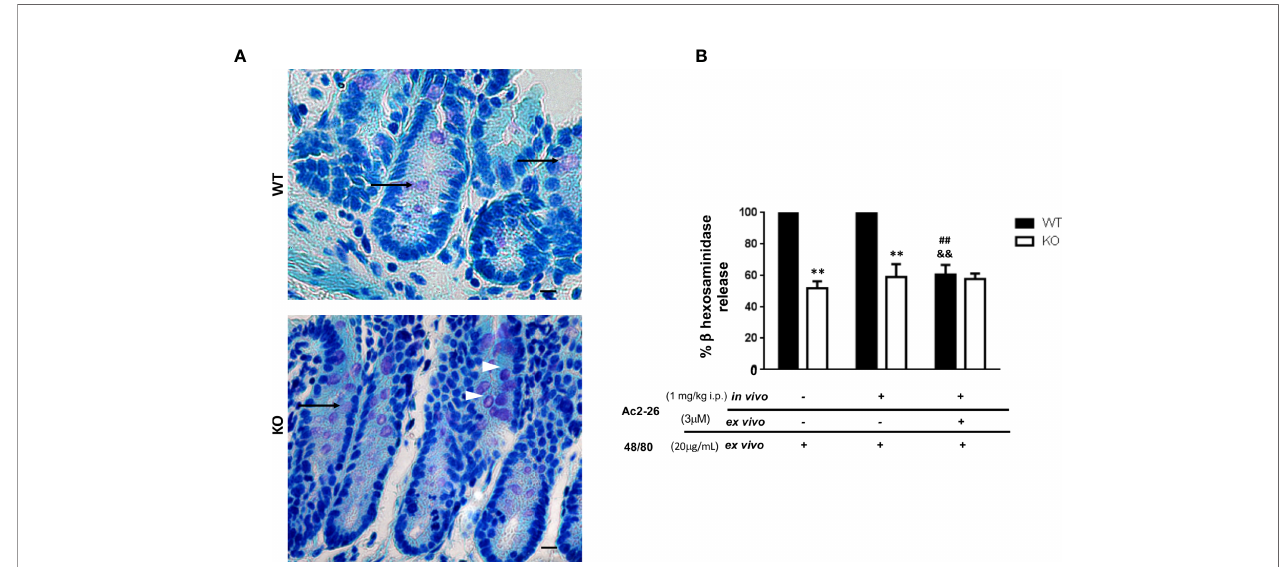
FIGURE 2 | Effect of peptide Ac2-26 on MC degranulation in colon explants. C57BL/6 WT and C57BL/6 interleukin-4- KO mice were pre-treated with PBS (-) or 3µM Ac2 -26 (+) and stimulated with 20µg/mL compound 48/80 ex vivo for 24 (h) (A) Representative colon sections with examples of intact (arrowheads) and degranulated (arrows) MCs. Staining: Toluidine Blue. Sections: 4 m m. Scale bars: 20 m m. (B) Degranulation of MCs was assessed by an enzymatic assay. Experiments were performed twice with n = 4 animals/group. Values of the percentage of b hexosaminidase release are expressed as the mean ± S.D., n = 8. Data were analyzed